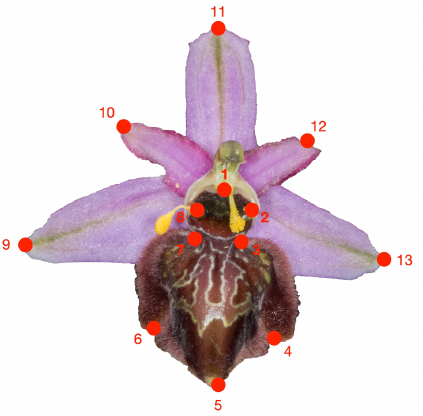
Figure 2. Positions of the 13 landmarks on an Ophrys aveyronensis flower. 1: Top of stigmatic cavity; 2-8: Position of pseudo-eyes; 3-4-6-7: Labellum inlets; 5: Tip of the labellum; 9-11-13: Tips of each sepal; 10-12: Tips of each